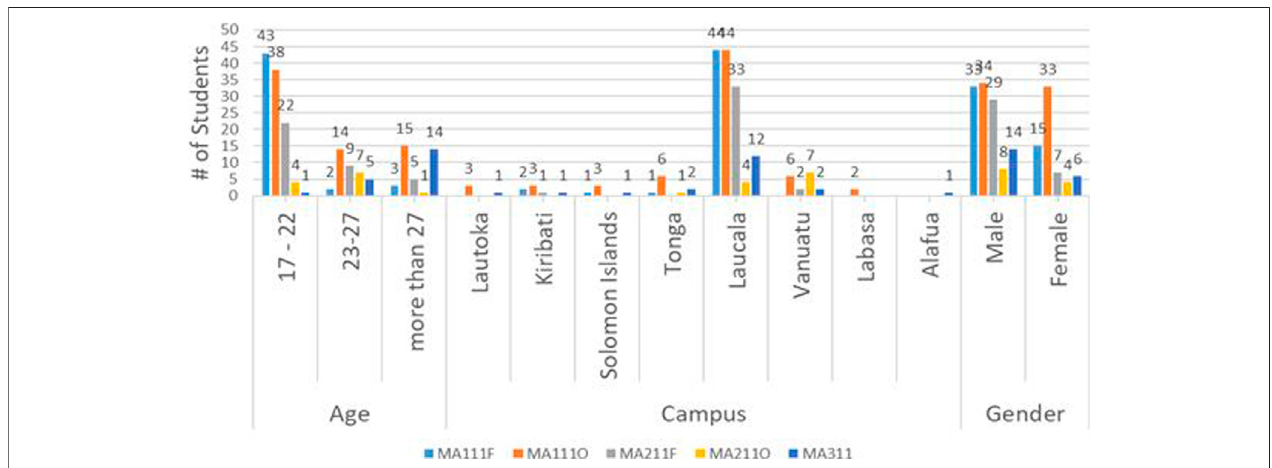
FIGURE 1 | Participants ’ demographics.